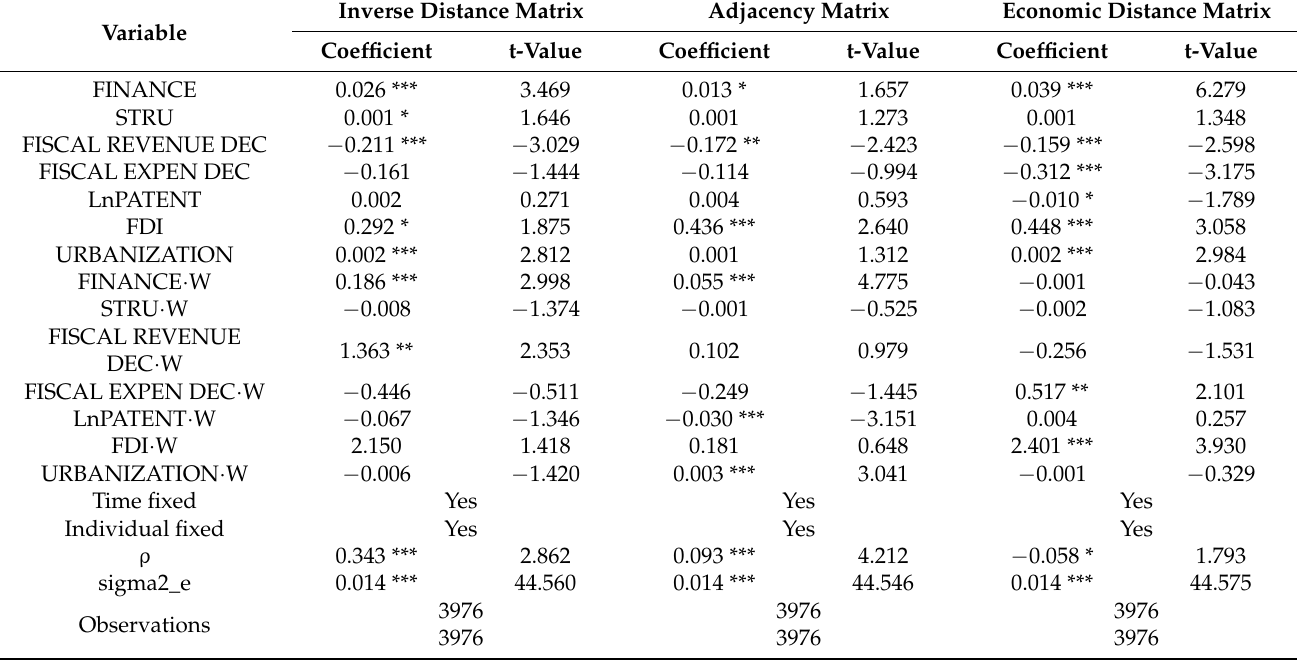
Table 7. Spatial regression